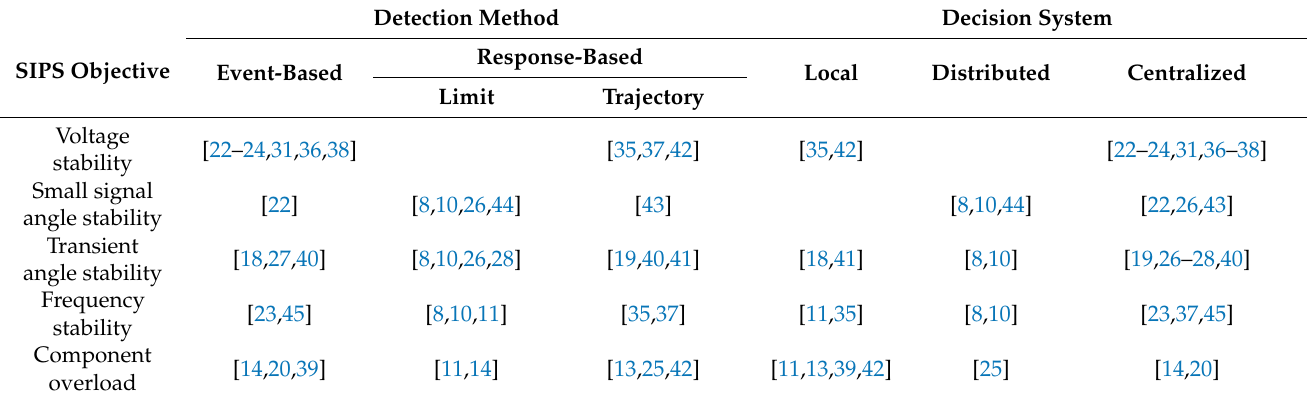
Table 3. SIPS literature classification part